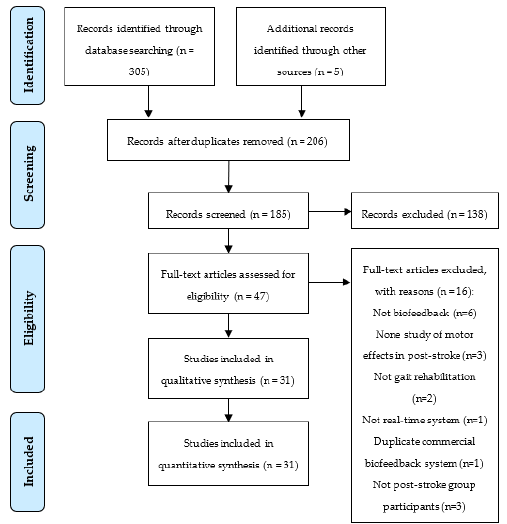
Figure 1. Flow diagram of search strategy based on